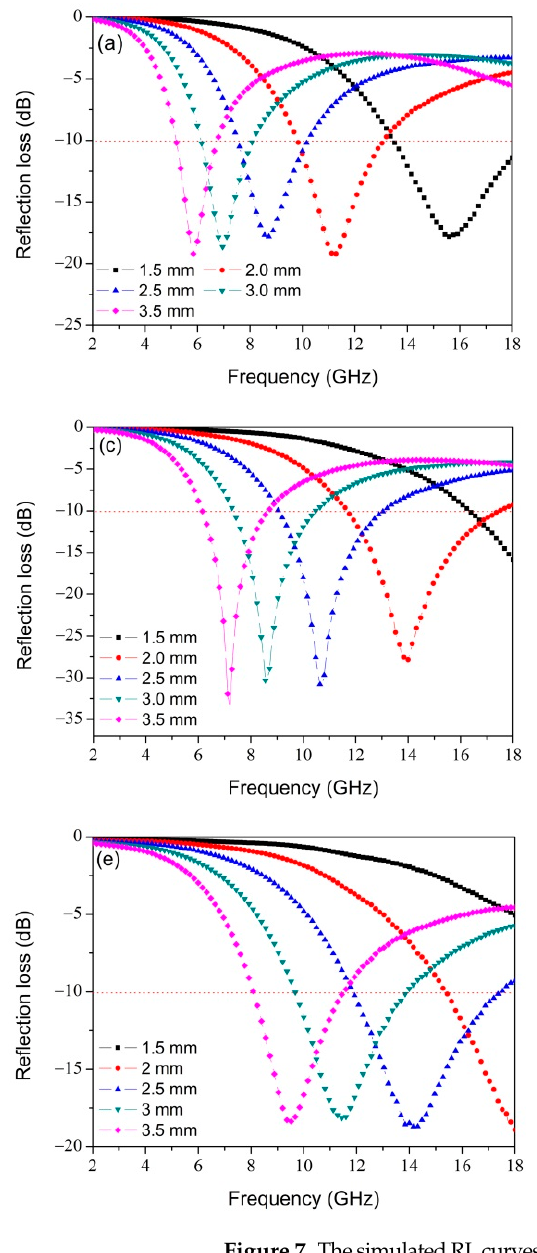
Figure 7. The simulated RL curves of ( a ) CCF, ( b ) NiFe 2 O 4 /CCF-1, ( c ) NiFe 2 O 4 /CCF-2, ( d ) NiFe 2 O 4 /CCF-3, and ( e ) NiFe 2 O 4 /CCF-4 at different thicknesses. ( f ) RL curves at 2.5 mm thickness for these five samples. Table 1. Microwave absorption performance of some reported carbon-based absorbents.